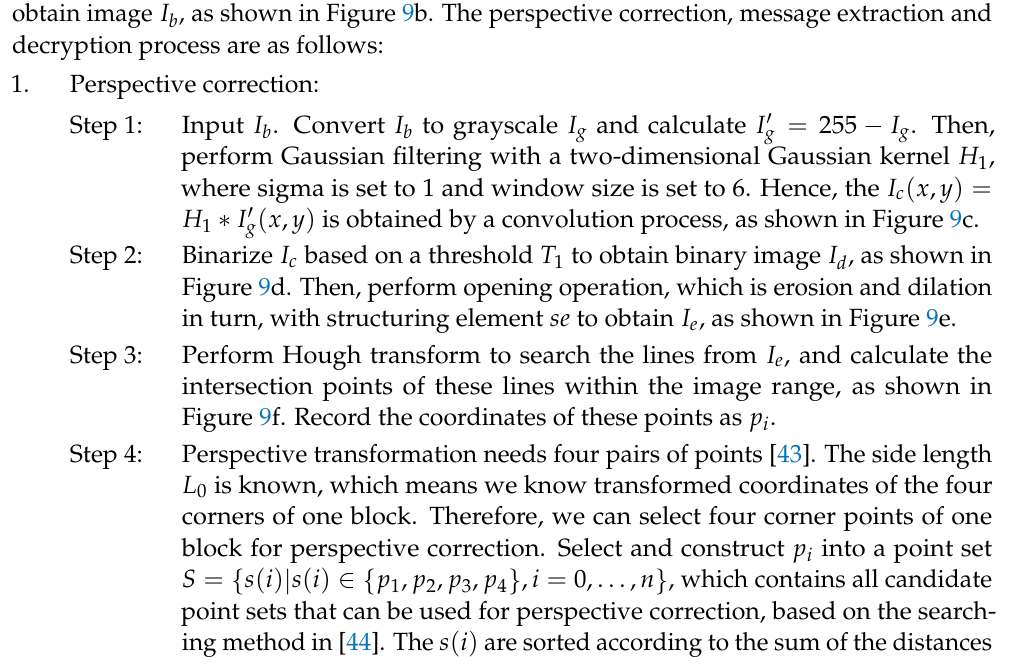
Figure 9f. Record the coordinates of these points as p i